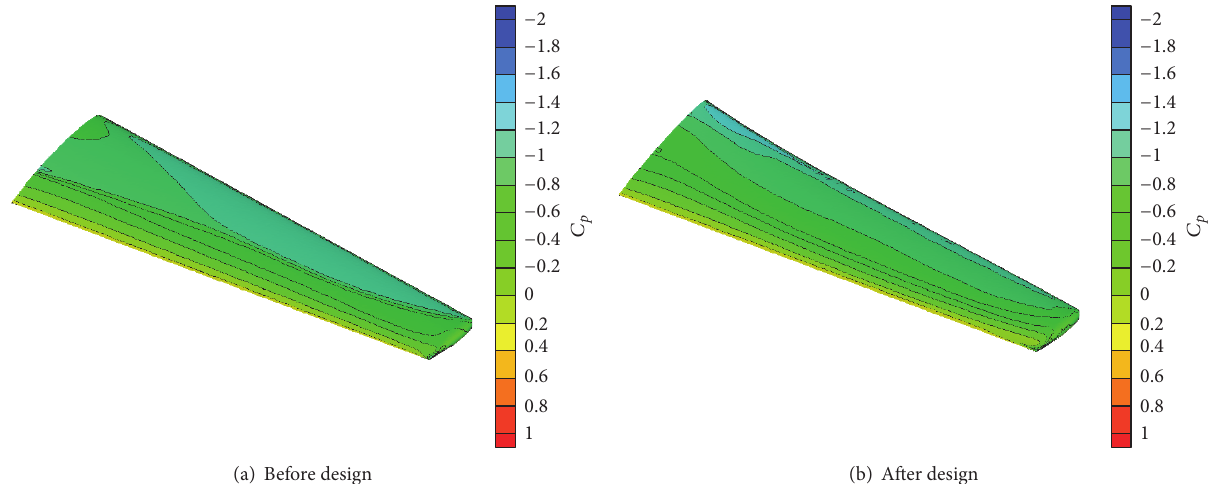
Figure 9: Contours of pressure coefficient of rigid wing.